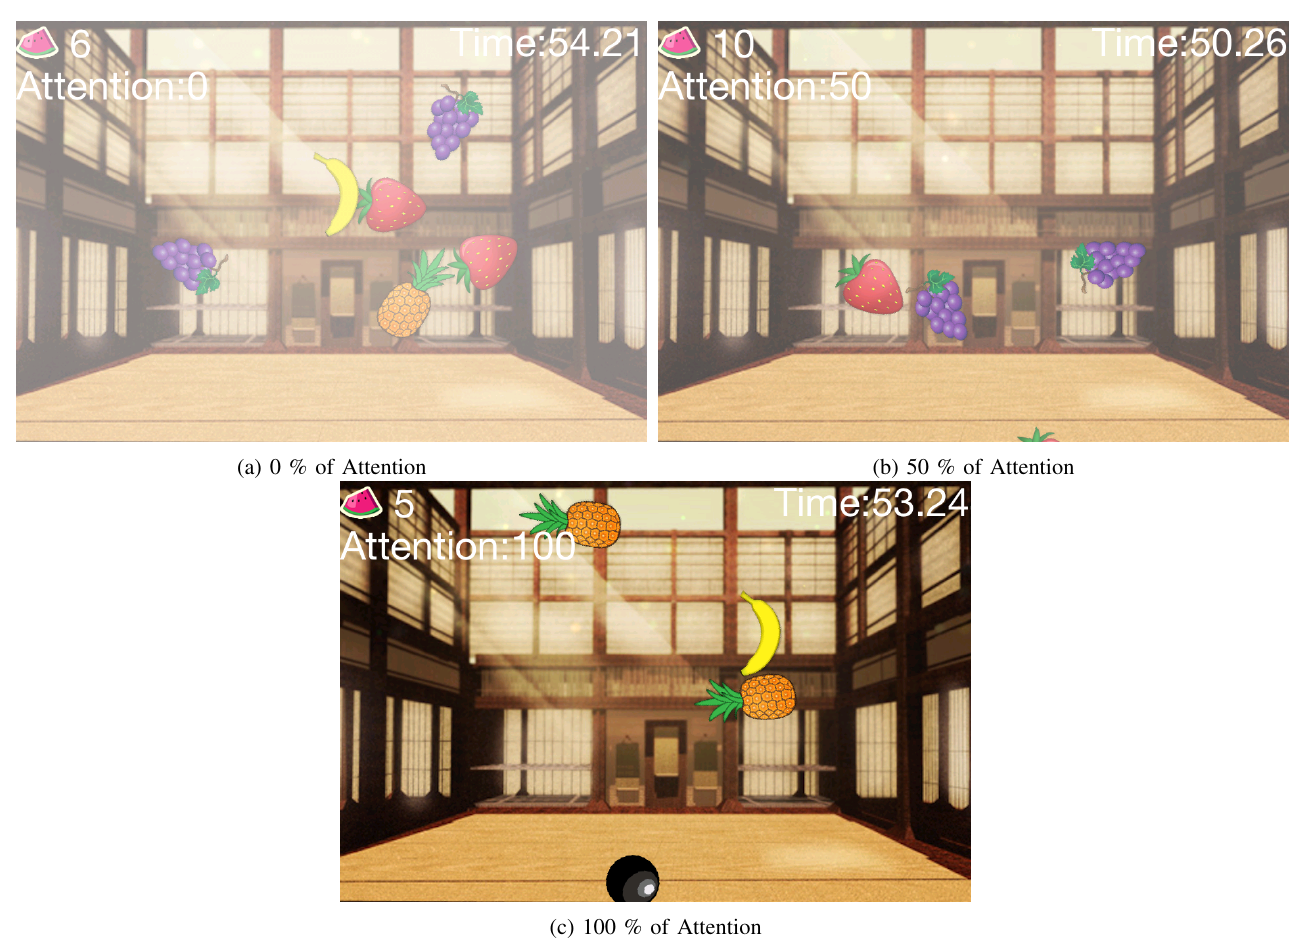
Figure 5: The MindNinja Game With different Attention Levels